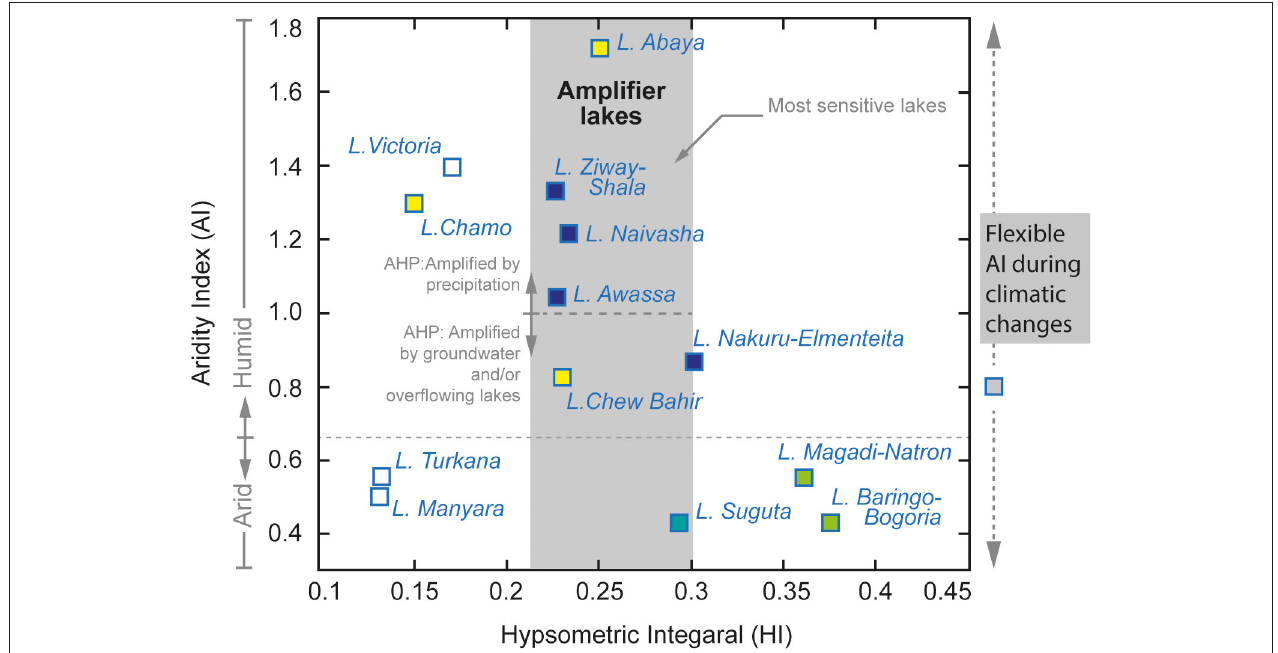
FIGURE 7 | The characterization of amplifier lakes: Hypsometric integral (HI) and Aridity Index (AI) of major lake basins within the EARS as published by Olaka et al. (2010) including new calculated values of paleo-lake Chew Bahir, Lake Abaya, and Lake Chamo (in yellow) from this study. Amplification of precipitation changes occurs in lakes with HI of 0.23–0.3 according to Olaka et al. (2010). We postulate that AI has changed in the course of climatic changes and thus amplification influences, such as groundwater and precipitation.